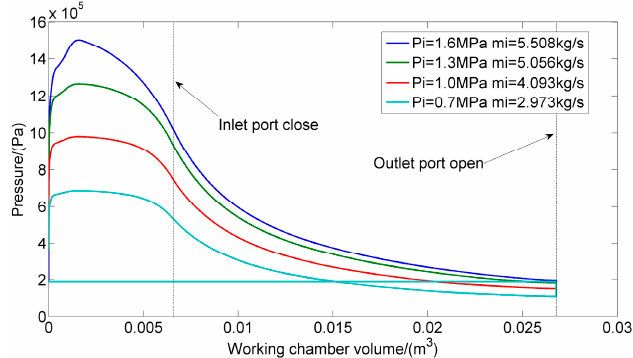
Figure 13. P ‐ V diagram for different inlet pressure ( P o = 0.19 Mpa, n = 2400 rpm).